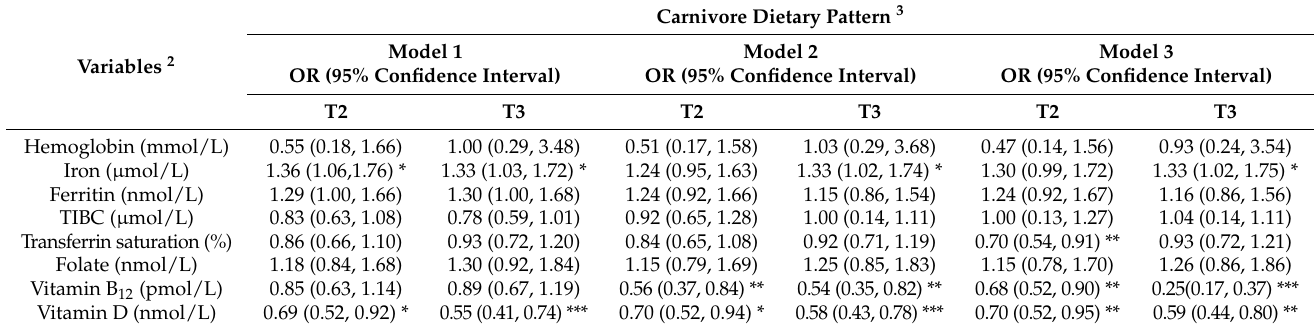
1 Three different models were performed in binomial logistic regression analysis: model 1, crude model; model 2, adjusted for age, region of residence, parity, and trimester; and model 3, adjusted for age, region of residence, parity, trimester, and daily dietary intake, such as energy (kcal), carbohydrate (% of energy), protein (g and % of energy), fat (g and % of energy), iron (mg), folate ( µ g), and vitamin D ( µ g). 2 Variables were divided into two levels on the basis of cutoff values in serum: hemoglobin, 6.52 mmol/L (10.5 g/dL); iron, 10.7 µ mol/L (60 µ g/dL), ferritin, 0.034 nmol/L (15 ng/mL); TIBC, 42.96 µ mol/L (240 µ g/dL); transferrin saturation, 16%; folate,